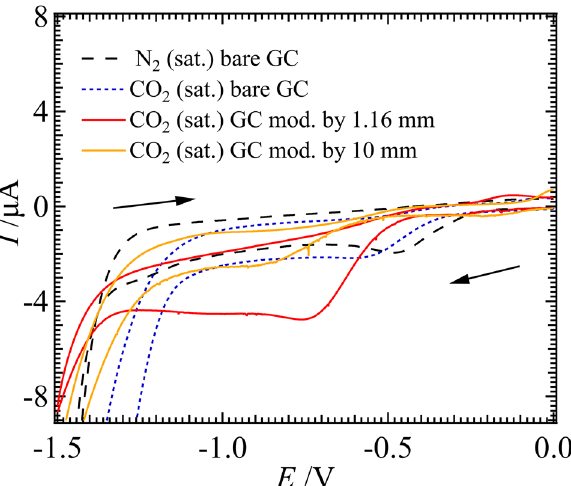
Figure 6. CVs recorded at a ~ 4 mm glassy carbon (GC) electrode immersed in a 0.1 M NaHCO 3 aqueous solution without (bare) and with (modified) a layer of Cu NP/poly-TT film deposited on the surface. Films were electrogenerated at the 1.16 or 10 mm ITIES using Cells 1 or 2, as indicated inset, with [TT] = 20 mM and [CuSO 4 ] = 5 mM, after 25 CV cycles at v = 0.020 V s –1 . CVs were recorded in 3-electrode mode using a Ag/AgCl reference (Dek Research) and Pt wire counter electrode at 0.050 V s –1